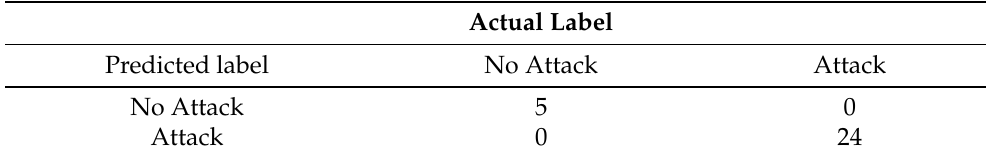
Table 9. Data exfiltration RF confusion